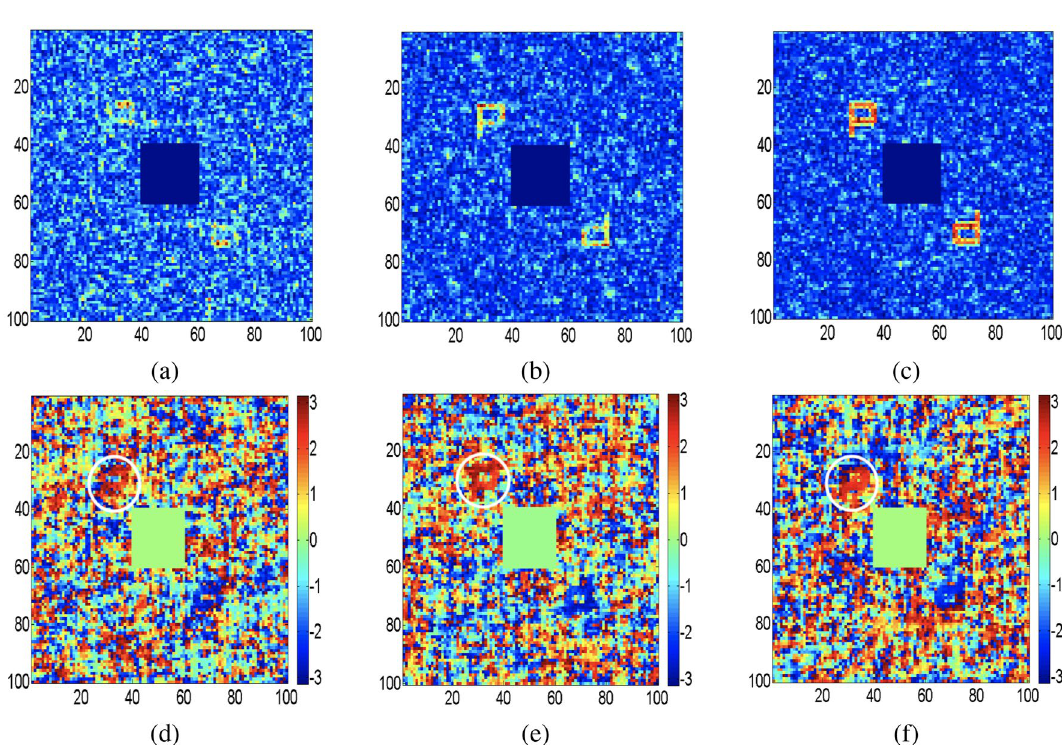
Figure 6. Recovery of the complex fields using STICH for three different M values: an off-axis hologram of letter “P” is used as transparency ( a , d ) Amplitude and phase distribution of object for M = 200 ; ( b , e ) Amplitude and phase distribution of object for M = 500 ; ( c , f ) Amplitude and phase distribution of object for M = 1000